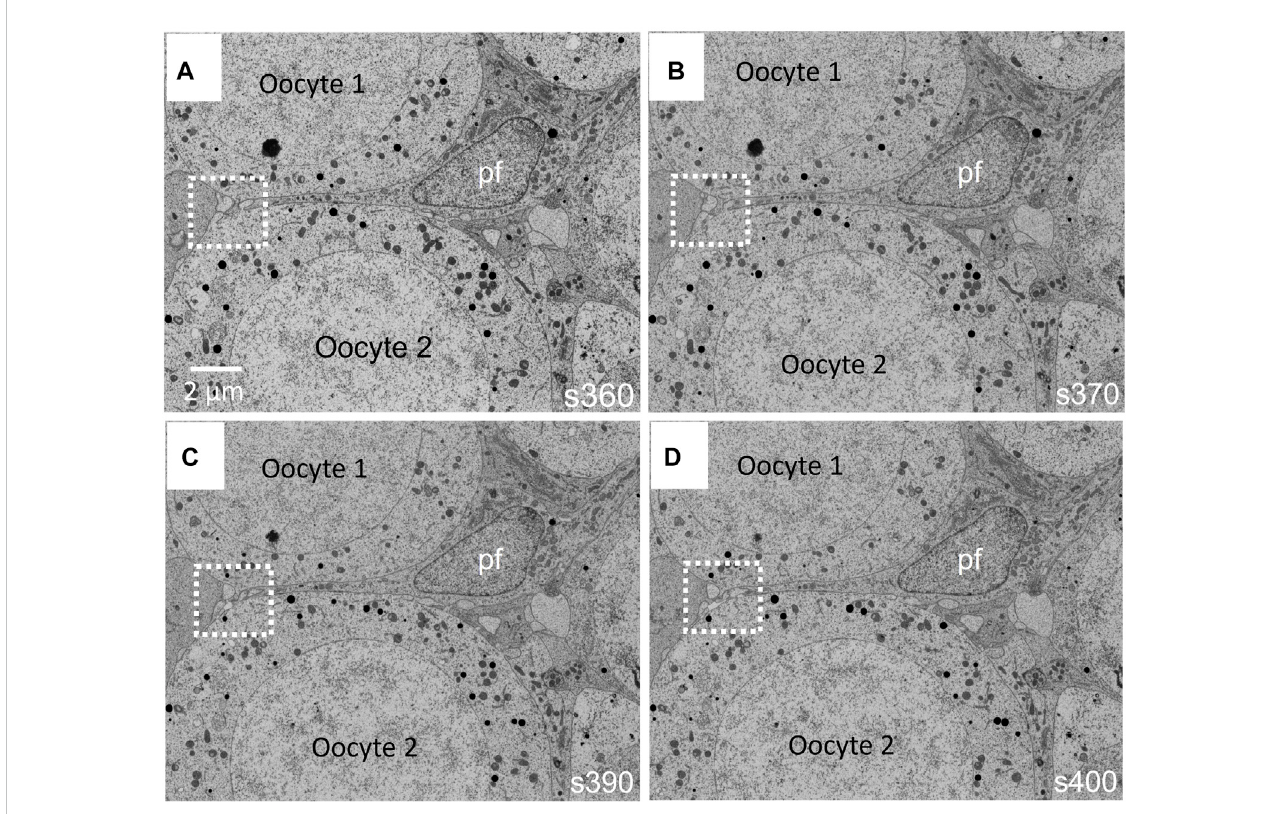
FIGURE 7 This is an ampli fi ed magni fi cation of the region shown in the dashed square of Figure 6. The pre-follicular cells (pf) were marked in Figure 6. The dashed box, visible in the movie shows the fi lopodia-like extensions, where oocytes make contact.